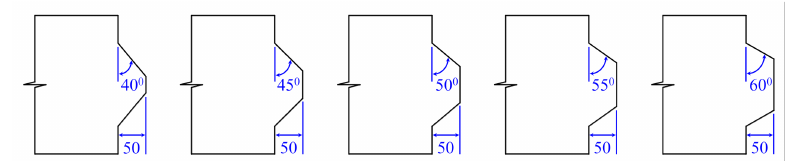
Figure 13. Bridge panels with different shear key angles (unit: